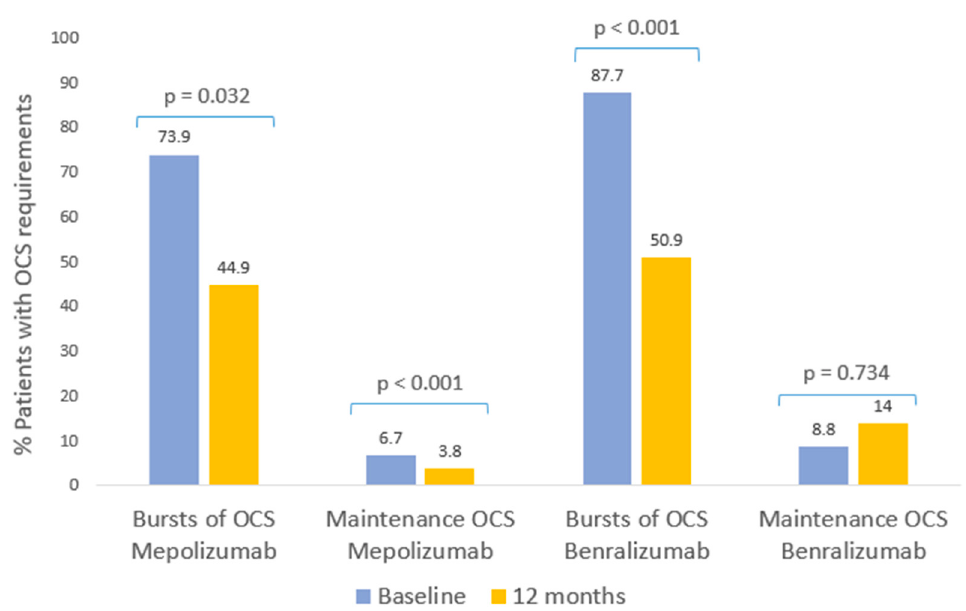
Figure 1. Clinical response to biological therapies: bursts of OCS and maintenance OCS. Patients with bursts of oral corticosteroid requirements and maintenance OCS during the 12 months prior to starting mepolizumab and benralizumab, and at the follow-up evaluation after 12 months of ther- apy.